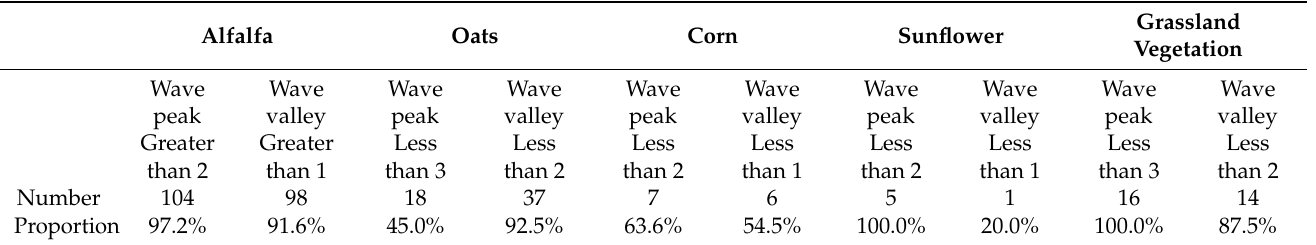
Table 2. Wave peak and valley numbers and proportions obtained from the NDVI series of different vegetation types derived from the MODIS data.